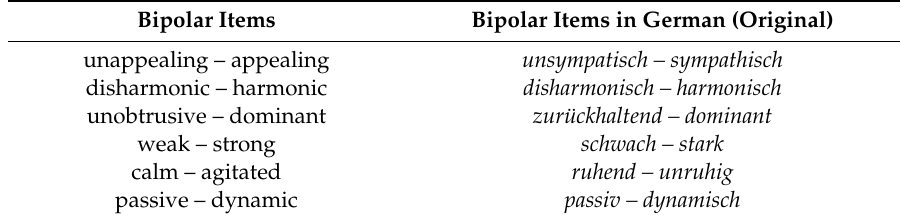
Table 1. Semantic di ff erential items used in the present study in German and translated into